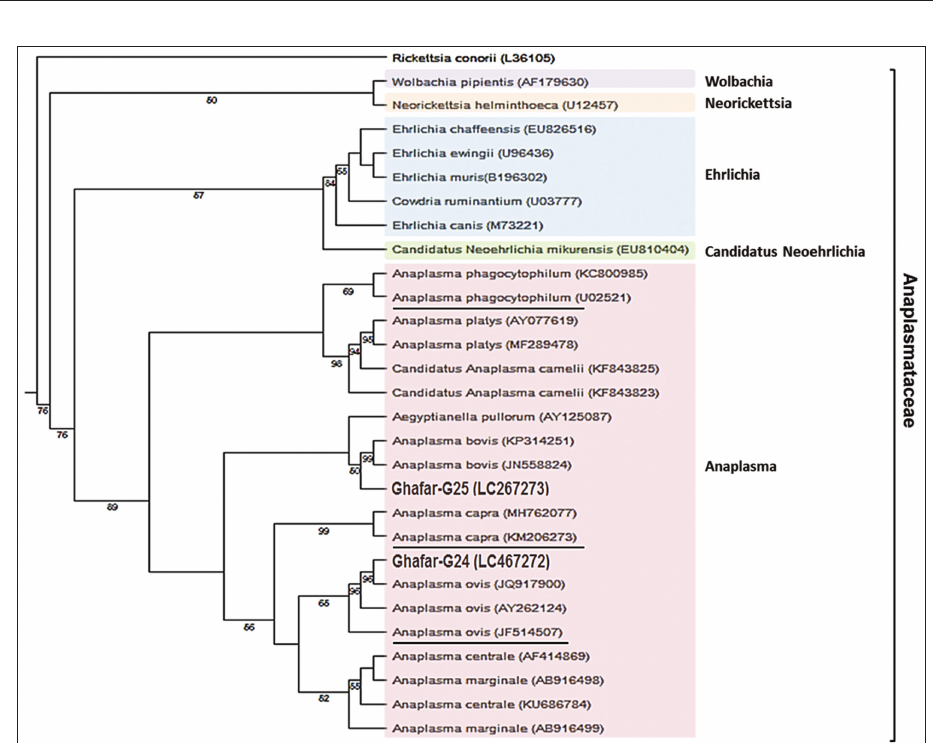
Figure-1: Neighbor-joining phylogenetic analysis of the 16S rRNA gene of detected Anaplasma spp. strains (bold) with selected designated Anaplasmataceae spp. Numbers at the nodes refer to bootstrap probabilities when they are above 50%. GenBank accession numbers are shown in parentheses and human pathogens are